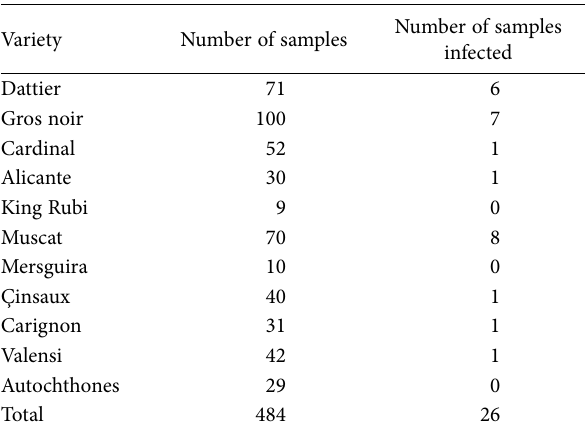
Table 1. Rates of virus infections in the surveyed grapevine varie-